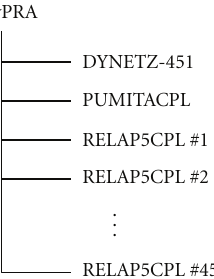
Figure 5: Tree view of processes running a coupled DyPRA simulation as a ps axjf command would show.